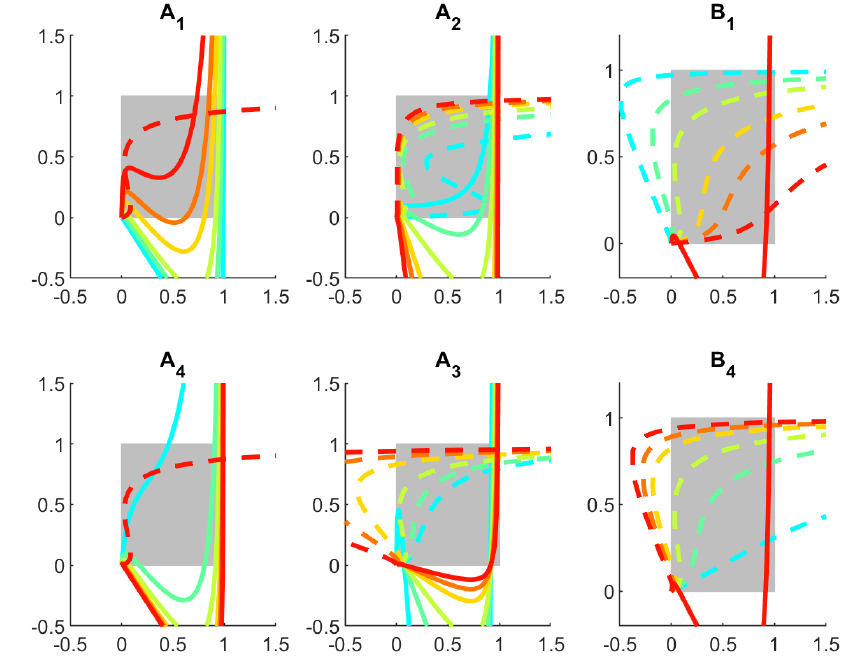
Figure A1. By modest variation in the individual parameter values by factors 0.1, 0.5, 1, 2, 3 and 5 of their default values, the effects on the nullclines and the steady states are observed. The grey region illustrates the physiological feasible range of the variables while a broader range is shown to emphasize the nullclines. Pairwise nullclines have the same color code while the X nullclines are full curves and the Y nullclines are stipulated.